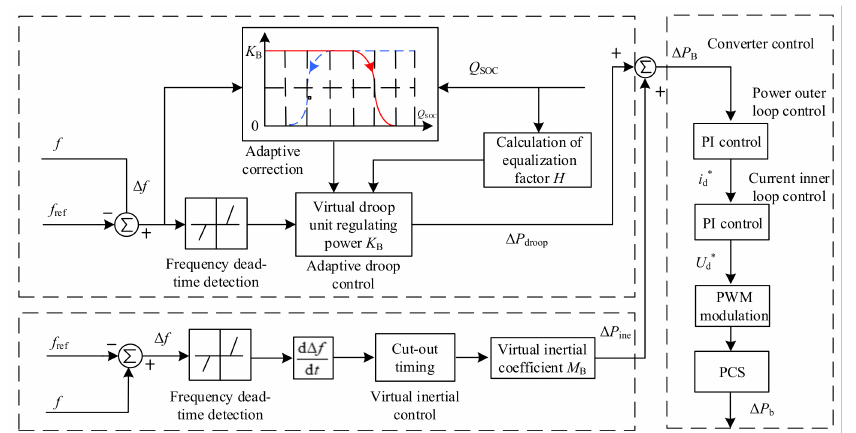
Figure 3. Primary frequency modulation comprehensive adaptive control strategy of